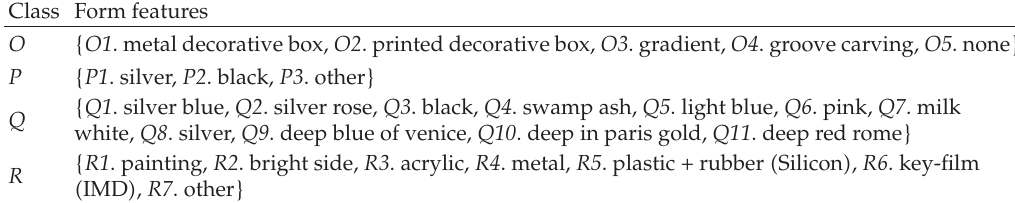
Table 4: Color and materials and their codes.